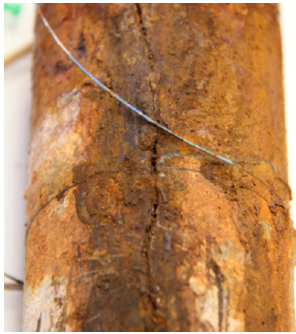
Figure 10. Strain history from FBG strain measurement.